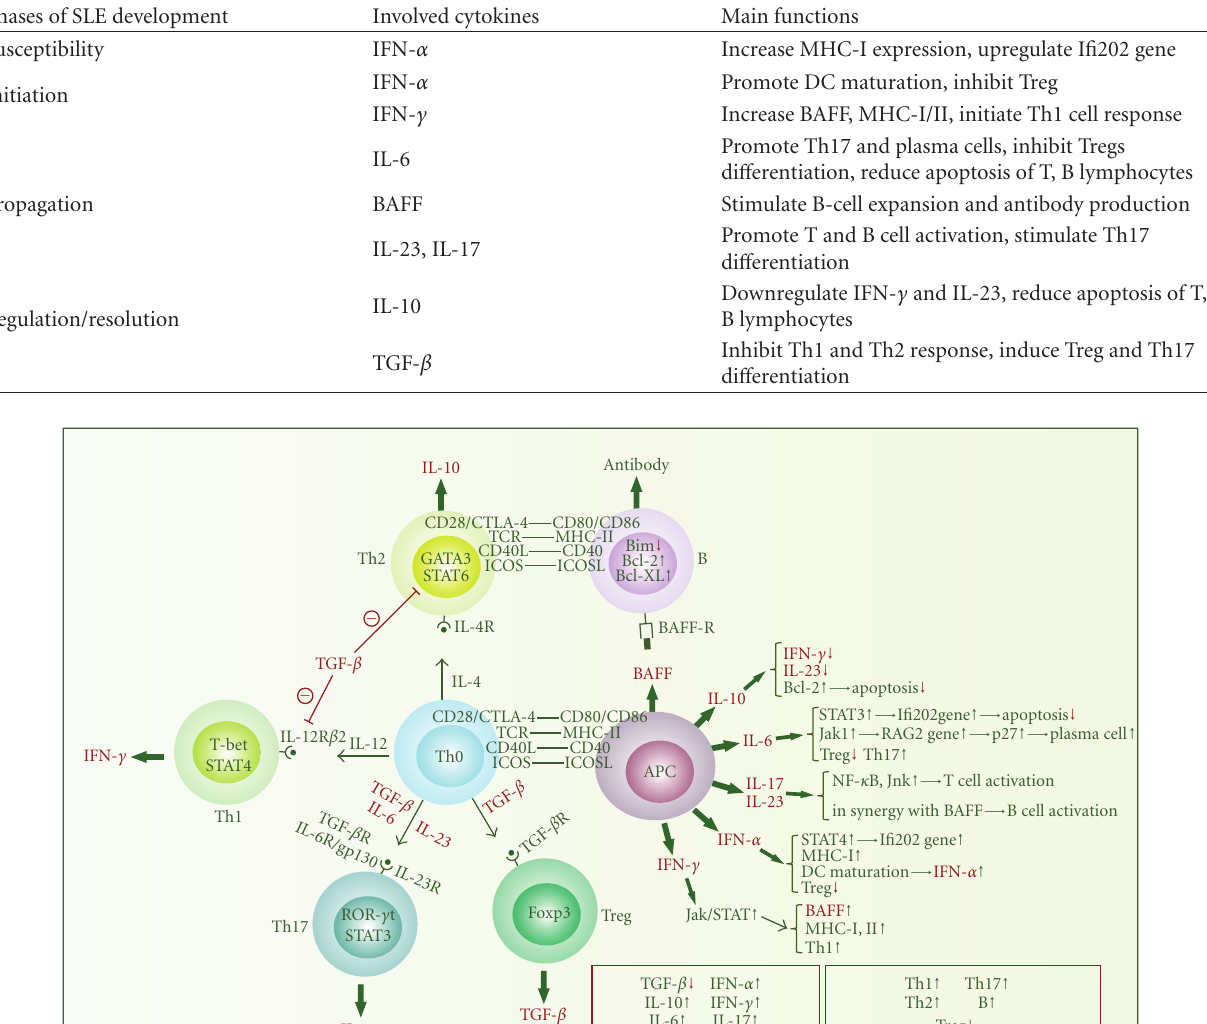
Table 1: Cytokine functions in di ff erent development phases of SLE.